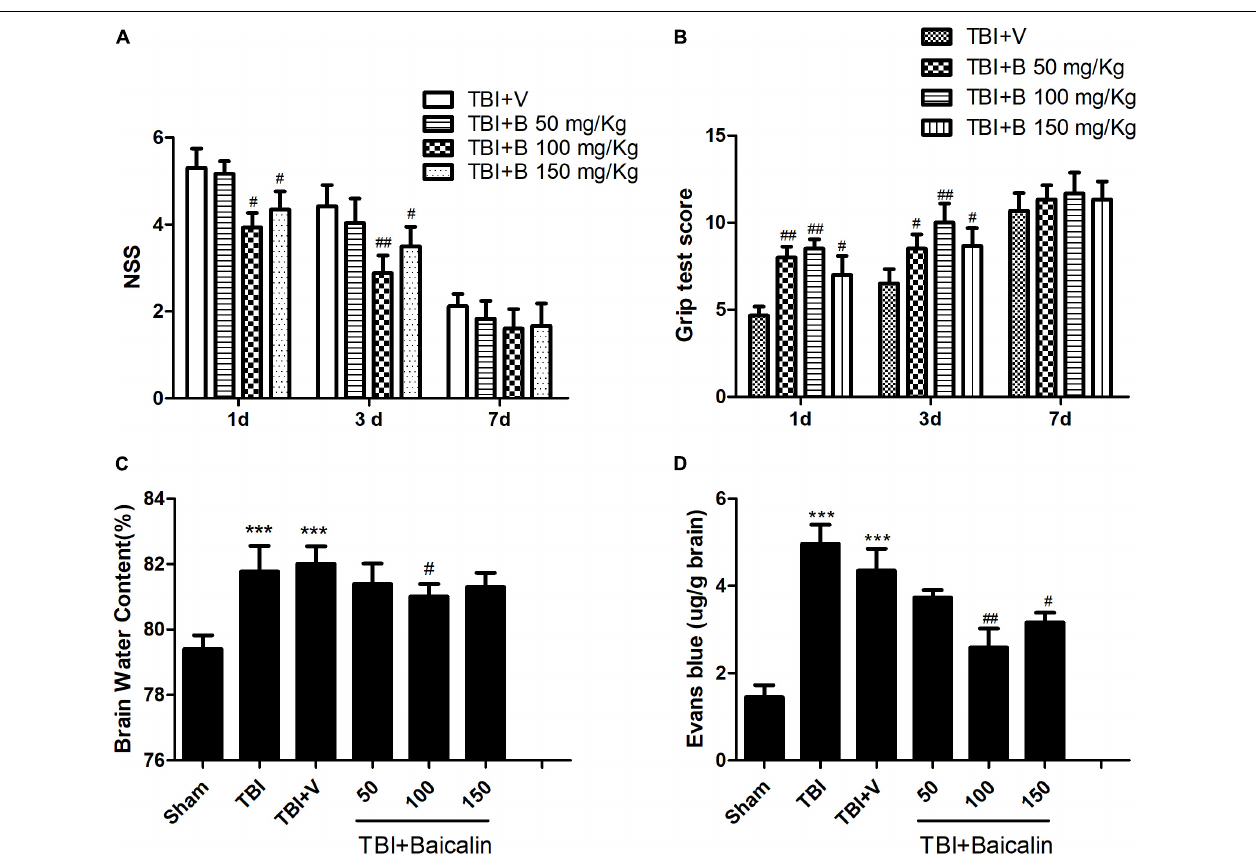
FIGURE 2 | Baicalin protected mice brain after TBI. (A,B) Compared with vehicle group, Baicalin administration significantly improved mice motor function at 1 and 3 days after TBI. A dose of 100 mg/kg exerted the best effects. (C,D) Compared with TBI+ V group, TBI induced increase of brain water content and extravasation of Evans blue dye were alleviated by administration of Baicalin. Dose of 100 mg/kg had the best effects. Data are represented as mean ± SD ( n = 6 per group). ∗∗∗ P < 0.001 compared with sham group; # P < 0.05 and ## P < 0.01 compared with the TBI+ V